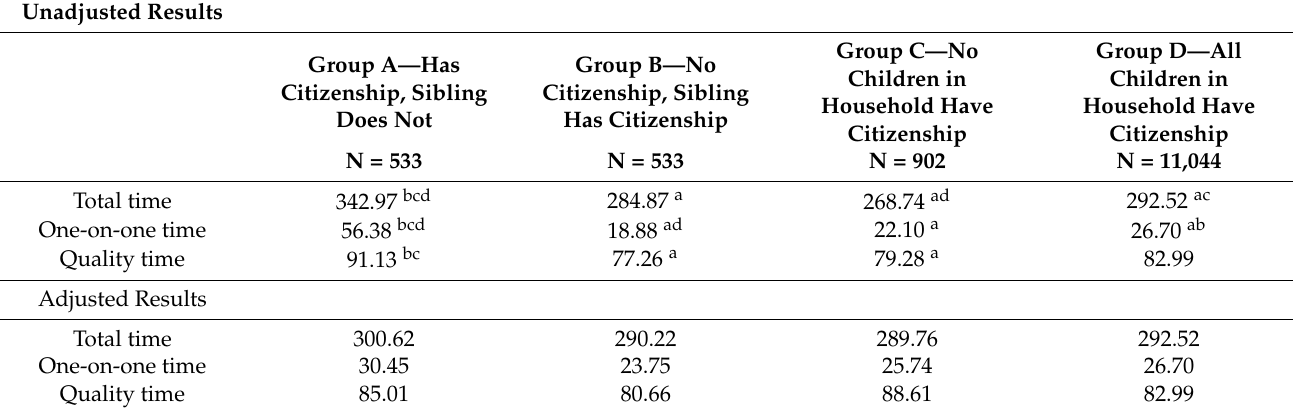
Table 2. Minutes Per Day of Parental Time Investments in Each